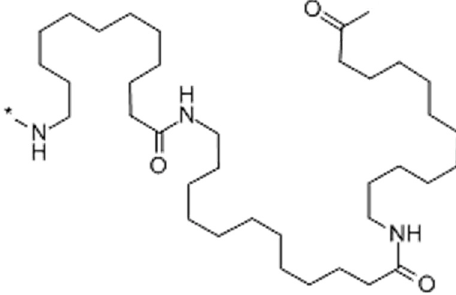
Figure 1. Polyamide 12 chemical structure.